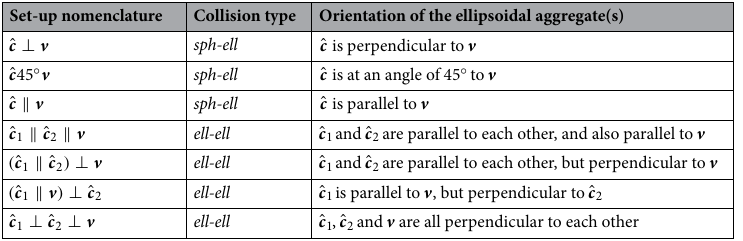
Table 1. Nomenclature of collision set-ups for sph-ell and ell-ell collisions.